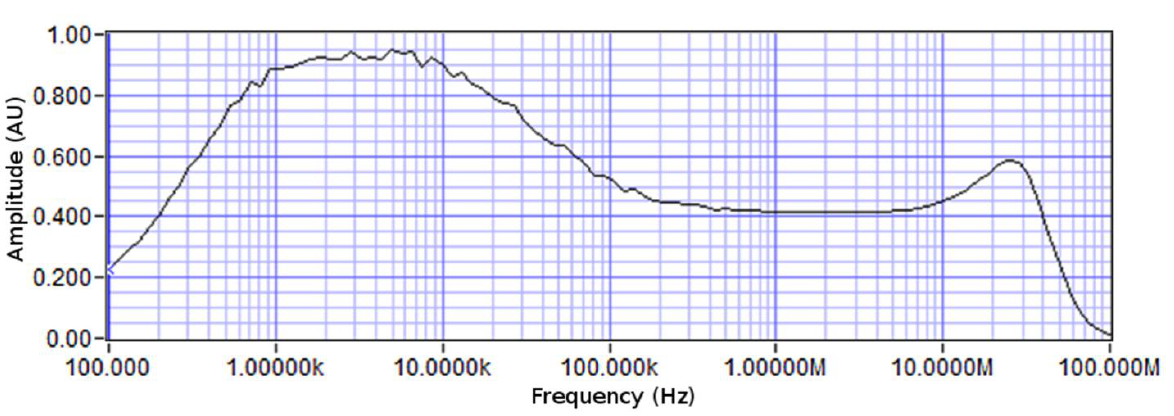
Figure 6. Spectral response of the impedance of electrode array with growth medium.